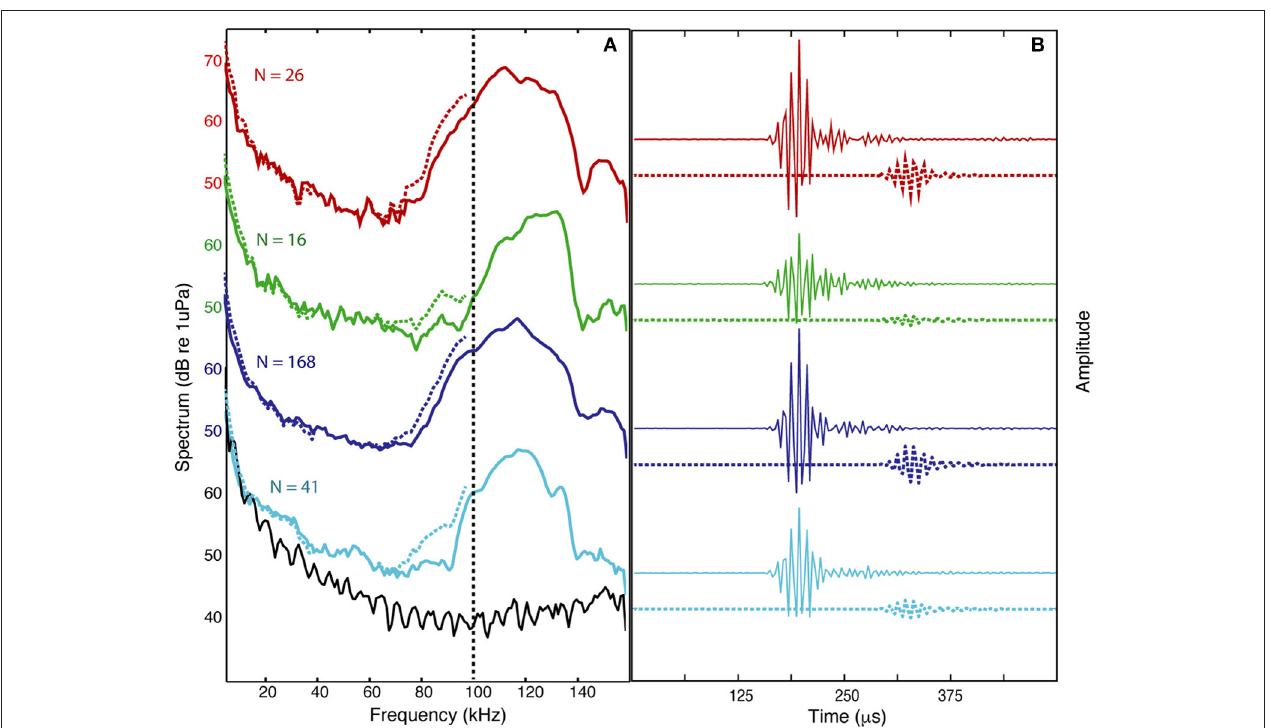
FIGURE 4 | Averaged spectrum levels (A) and average waveforms (B) are shown for all the clicks during each of four encounters ( N = number of clicks) recorded with 160kHz bandwidth (colored solid lines) and the estimated level that would result from 100kHz bandwidth recording (colored dashed lines) based on filtering and aliasing of high frequency energy (filtered waveforms are delayed by 125 µ s for clarity). The instrumental spectrum noise-floor shown (black line) associated with light blue encounter.